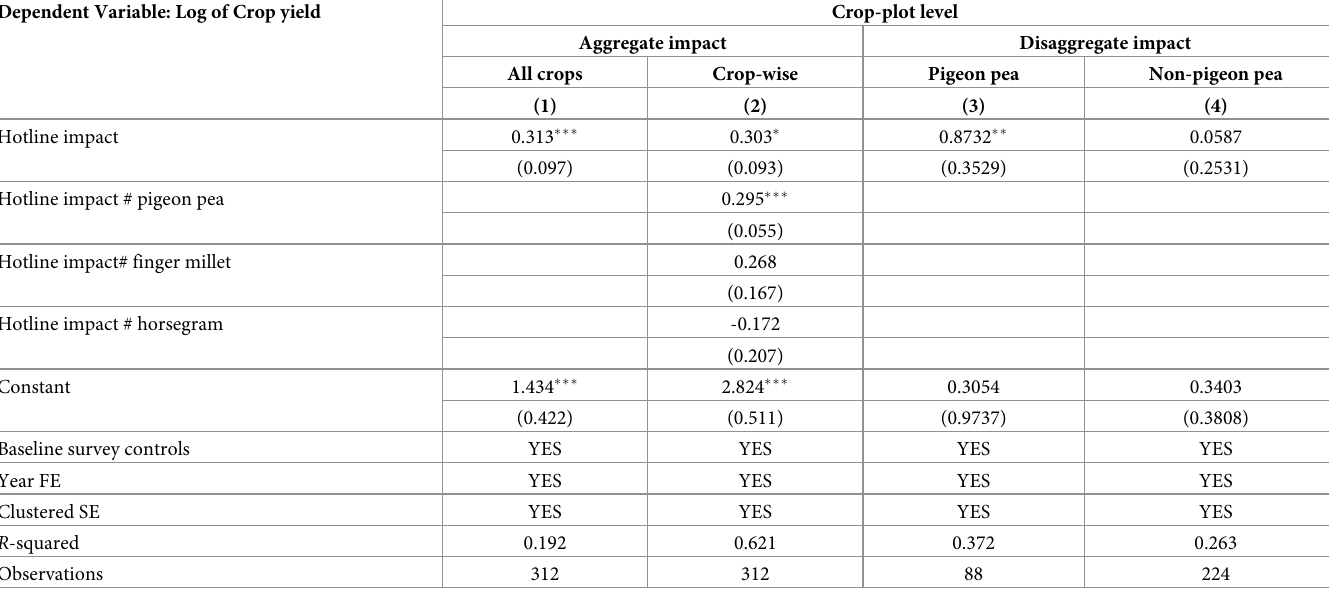
Table 1. Regression of crop yield on hotline impact, crop-specific hotline impact, and baseline survey